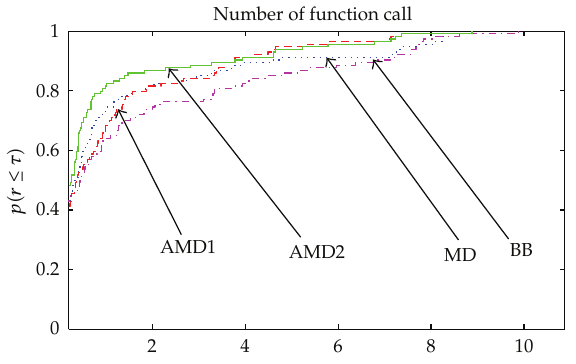
Figure 2: Performance profile based on function